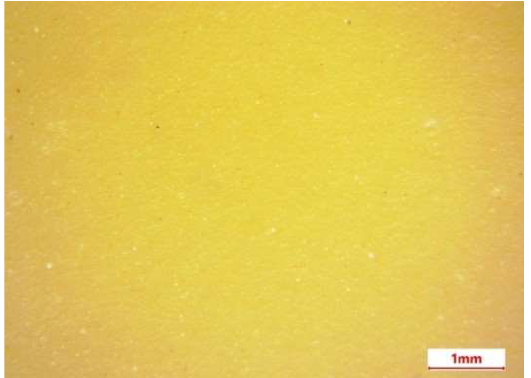
Figure 5. Optical micrographs of the biopolymer nanofilled films formed according to the optimal technological parameters of the process.